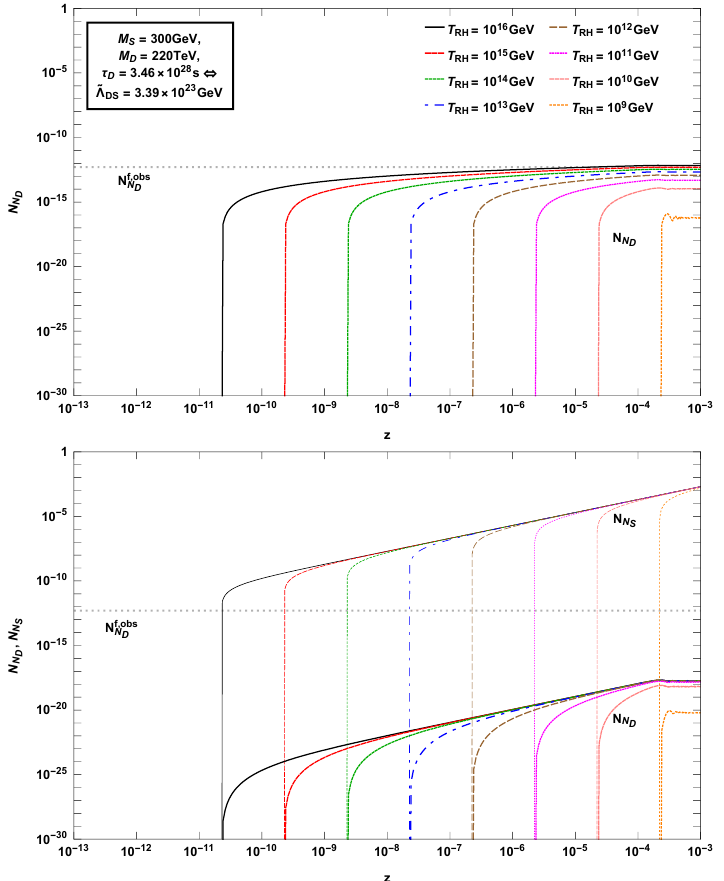
Figure 2 . Evolution of the source and dark neutrino abundances for different values of the initial temperature and for the indicated benchmark values of M D , M S and τ D . Top panel: initial thermal N N -abundance. Bottom panel: initial vanishing N N S